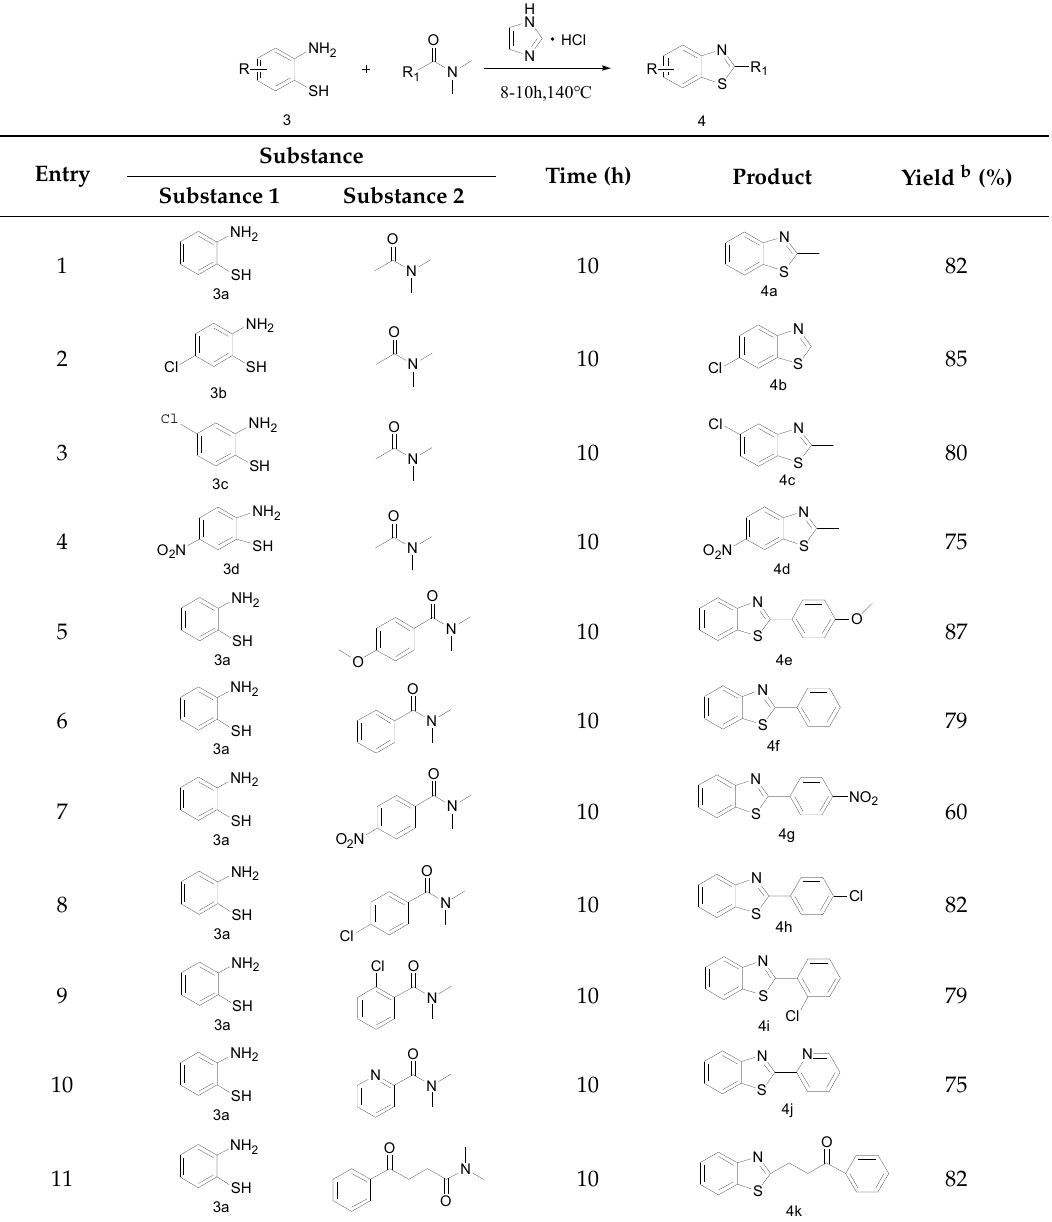
Table 4. Substrate scope with respect to substituted 2-aminothiophenols a.